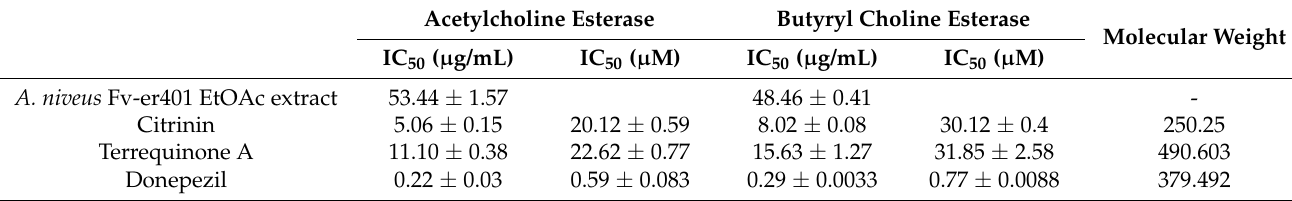
Table 2. Cholinesterase inhibitory activity studies. Acetylcholine Esterase Butyryl Choline